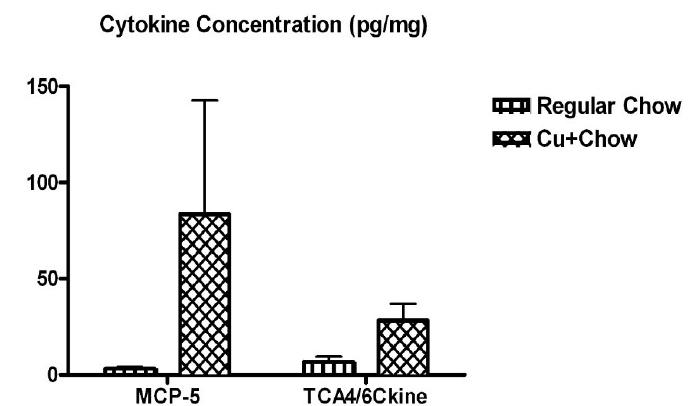
Figure 5. Dietary Cu exposure heightened cerebral pro-inflammatory cytokines in APP / PS1 transgenic